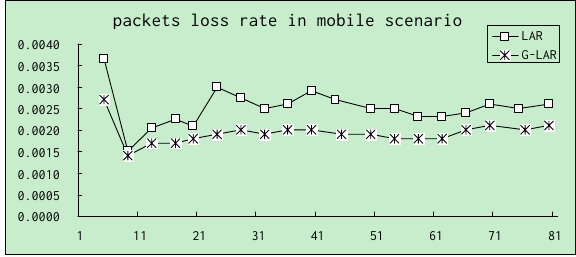
Fig. 12. Packets loss rate in mobile